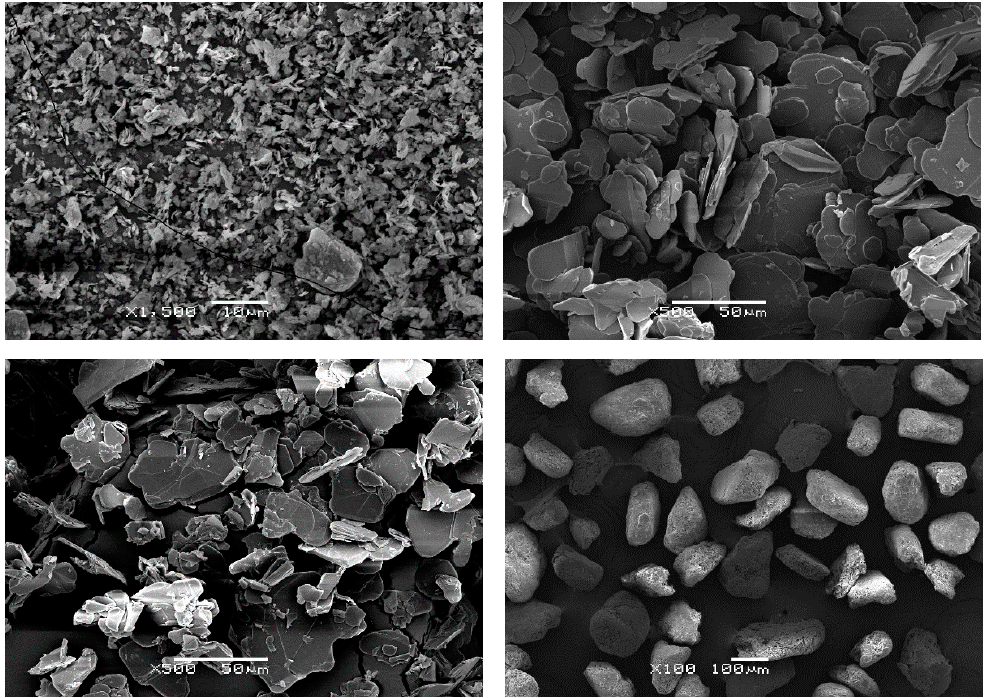
Figure 2. SEM micrographs of boron nitride (BN) particles from Saint-Gobain [17]: top left, 2 μ m Figure2. SEMmicrographsofboronnitride(BN)particlesfromSaint-Gobain[17]: topleft, 2 µ mplatelets, platelets, PCTP2; top right, 30 μ m platelets, PCTP30; bottom left, 180 μ m platelets, PCTP30D; bottom PCTP2; top right, 30 µ m platelets, PCTP30; bottom left, 180 µ m platelets, PCTP30D; bottom right, right, 120 μ m low density agglomerates, PCTL7MHF. 120 µ m low density agglomerates,